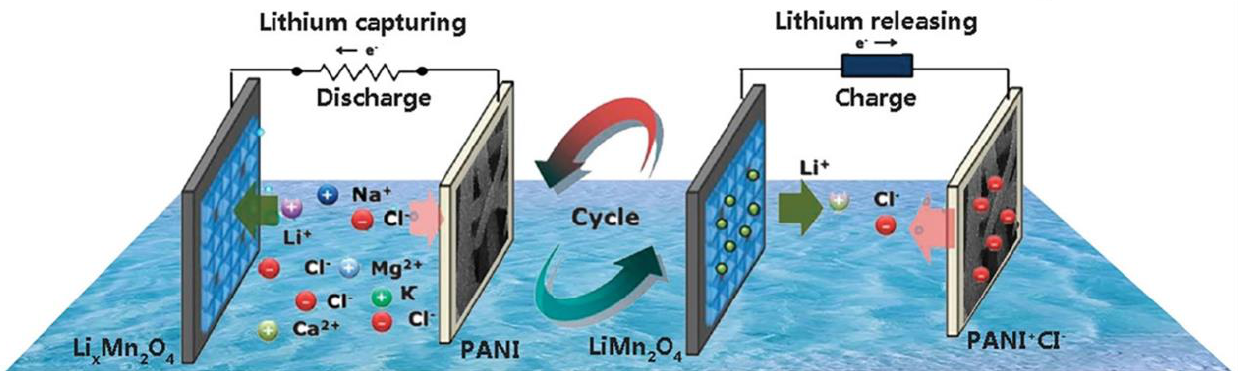
Figure 3. Schematic of the Li + capturing process in source water. Reprinted with permission from Ref. [38]. Copyright 2019 Chemistry Europe.